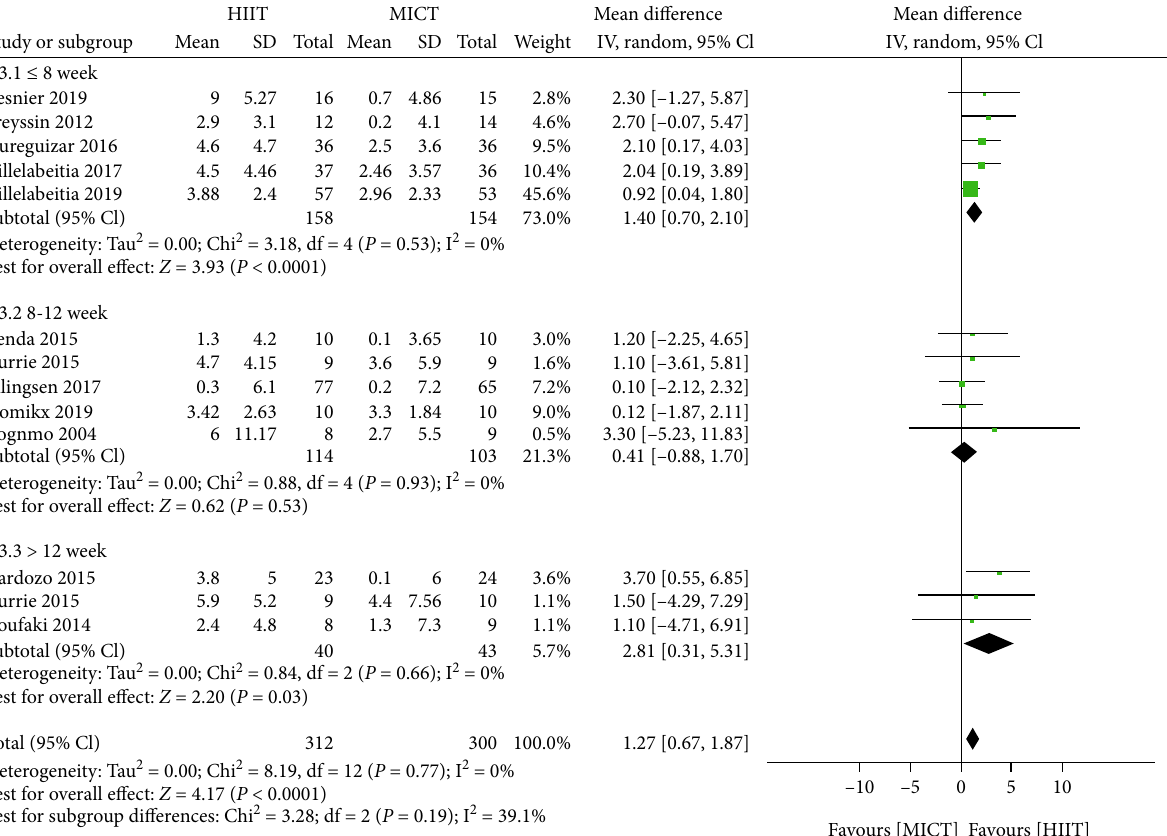
Figure 5: Subgroup analysis of HIIT and MICT on peak VO high-intensity interval training; MICT: moderate-intensity continuous training; peak VO disease; HF: heart failure; SD: standard deviation; CI: con fi dence patients; mean di ff erence of 3.52%, 95% CI − 2.54% to 9.59%, P = 0 : 25 , I 2 = 10 % , Z = 1 : 14 ; Figures 6(c) and 6(d)).